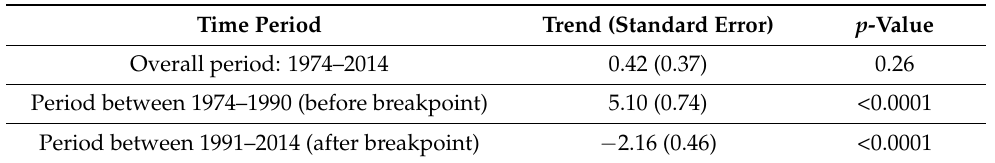
Table 2. Change in the number of days during harvest with maximum temperature over 35 ◦ C per year between 1974–1990 and